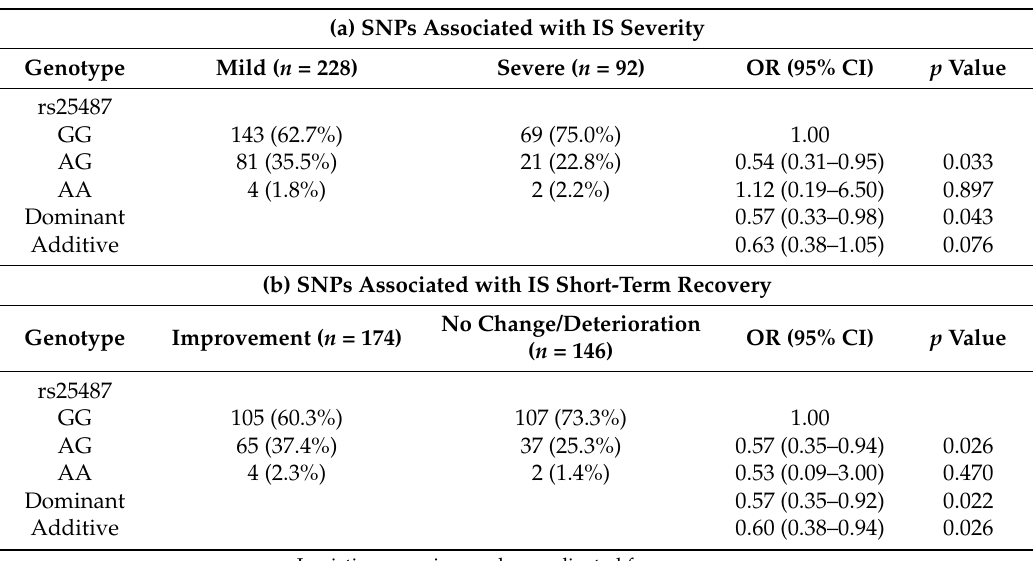
Table 3. Association of XRCC1 rs25487 polymorphism with IS severity and short-term recovery.